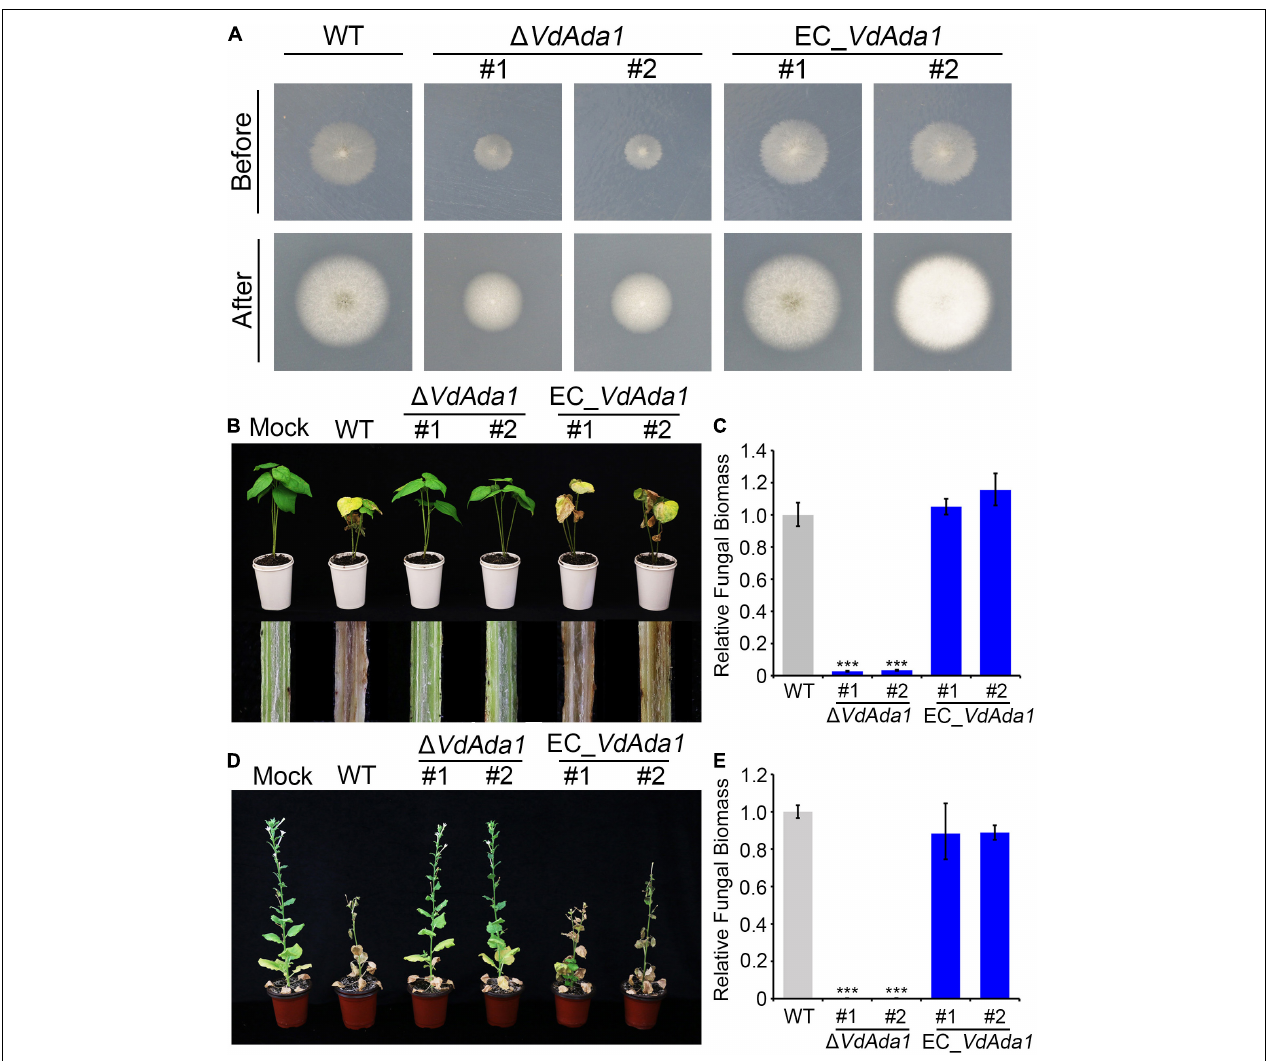
FIGURE 4 | VdAda1 is required for the full virulence in Verticillium dahliae . (A) The first row shows colonies of the wild type, (cid:49) VdAda1 , and EC_ VdAda1 strains grown on minimal medium (MM) overlaid with a cellophane layer at 3 dpi (before). Photographs in the second row were taken at 5 days after removal of the cellophane layer (after). (B) Phenotypes of 2-week-old cotton seedlings inoculated with agar plug (Mock), hyphae from PDA agar cultures of wild type V. dahliae strain AT13, the (cid:49) VdAda1 mutant strains, and complemented strains. The virulence phenotypes were photographed at 14 dpi. The disease symptoms are shown at the top, and the discoloration of the inoculation shoot longitudinal sections is shown at the bottom. (C) The fungal biomass of (cid:49) VdAda1 strains, and EC_ VdAda1 strains on cotton were detected by quantitative PCR (qPCR). V. dahliae elongation factor 1- α ( VdEF-1 α ) was used to quantify fungal colonization. The cotton 18S gene was used as endogenous plant reference gene. Error bars represent the standard deviation calculated from three replicate experiments compared with the wild type. ***, significant differences ( P < 0.001) using one-way analysis of variance (ANOVA). (D) Phenotypes of 5-week-old N. benthamiana plants inoculated with agar plug (Mock), hyphae from PDA agar cultures of wild type AT13, (cid:49) VdAda1 mutant, and complemented strains. The virulence phenotypes were photographed at 21 dpi. (E) The fungal biomass of (cid:49) VdAda1 strains, and EC_ VdAda1 strains on N. benthamiana were detected by qPCR. V. dahliae elongation factor 1- α ( VdEF-1 α ) was used to quantify fungal colonization. The N. benthamiana EF-1 α was used as endogenous plant reference gene. Error bars represent the standard deviation calculated from three replicate experiments, ***, significant differences ( P < 0.001) compared with the wild type using one-way analysis of variance